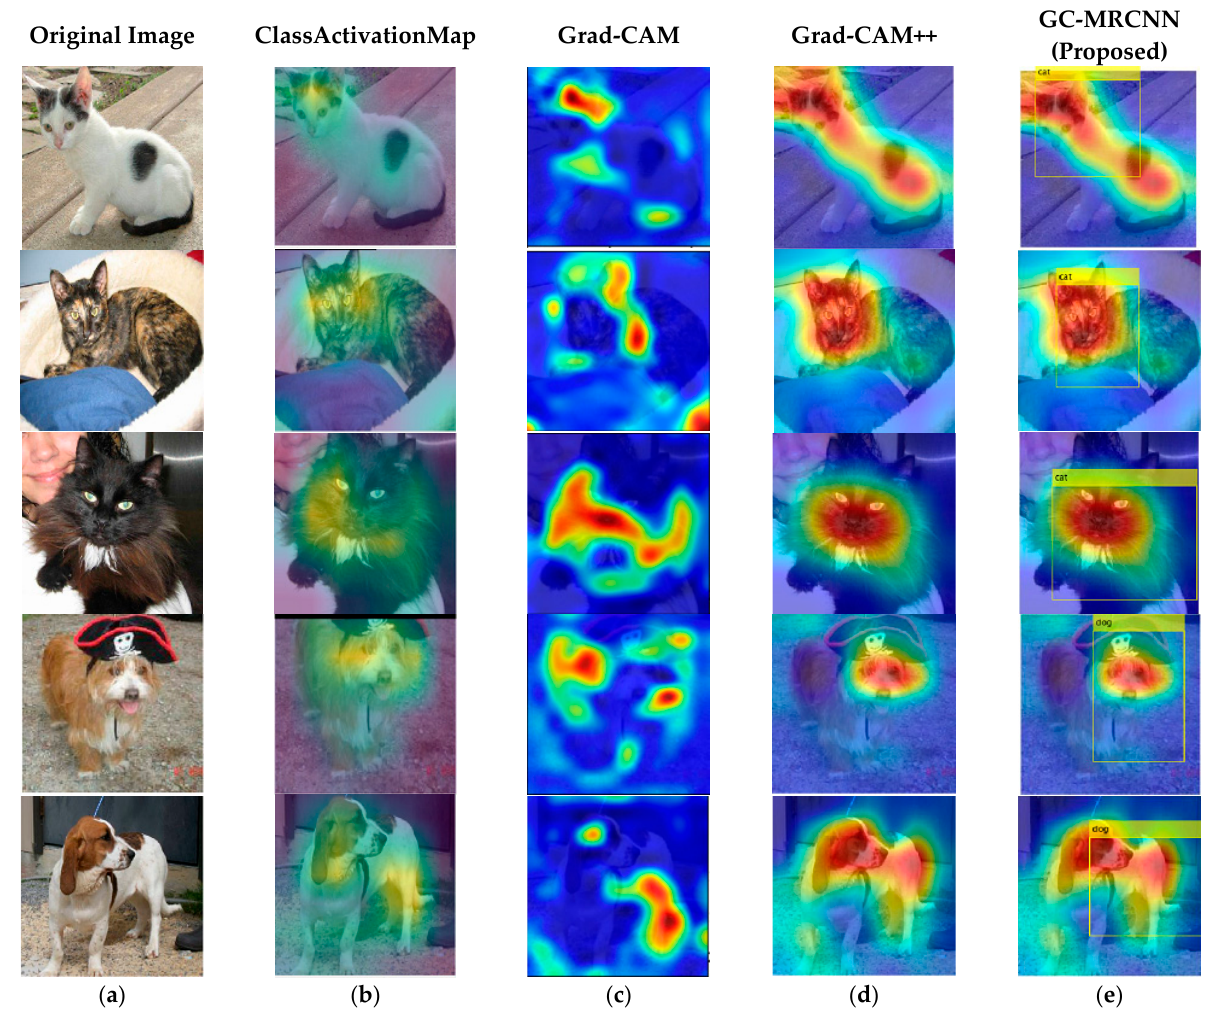
Figure 5. ( a ) Original image; ( b ) Class Activation Map; ( c ) Grad-CAM; ( d ) Grad-CAM++; and ( e ) GC-MRCNN (proposed).